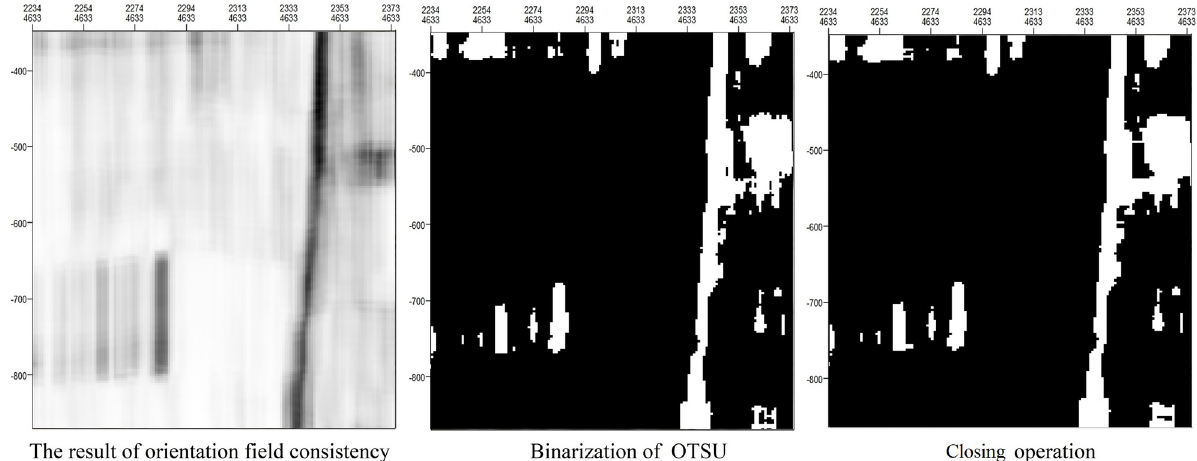
Fig 4. Fault areas extracted by means of the OTSU binarization method and the closing operation.